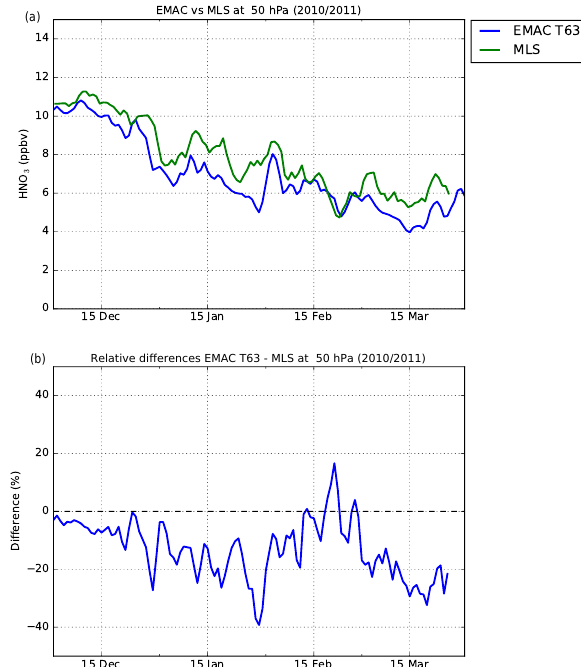
Figure 12. (a) Time series of HNO 3 (at 50hPa) from EMAC (blue) and Aura/MLS (green) for the Arctic winter 2010/2011 (1 Decem- ber 2011 to 31 March 2011, 70–90 ◦ N). (b) Relative differences of the EMAC–MLS time